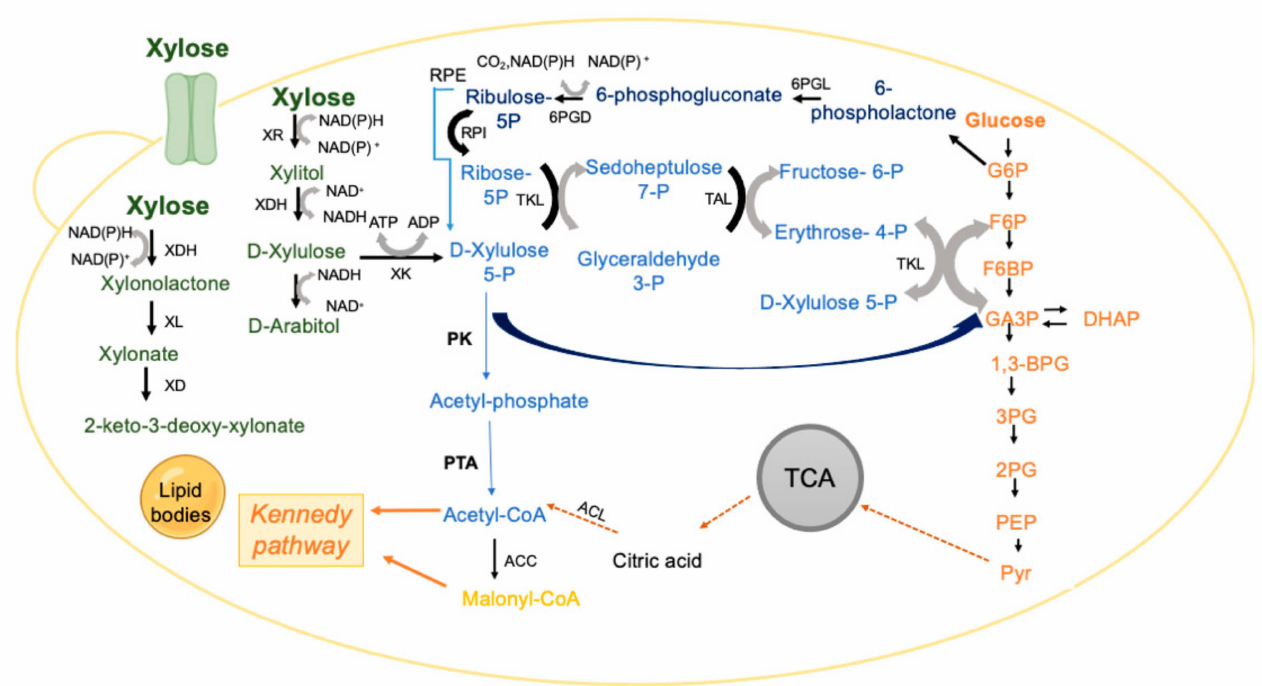
Figure 3. Metabolic pathways of xylose assimilation in yeast. The oxidative pentose phosphate pathway is highlighted in dark blue, and the non-oxidative pentose pathway is shown in light